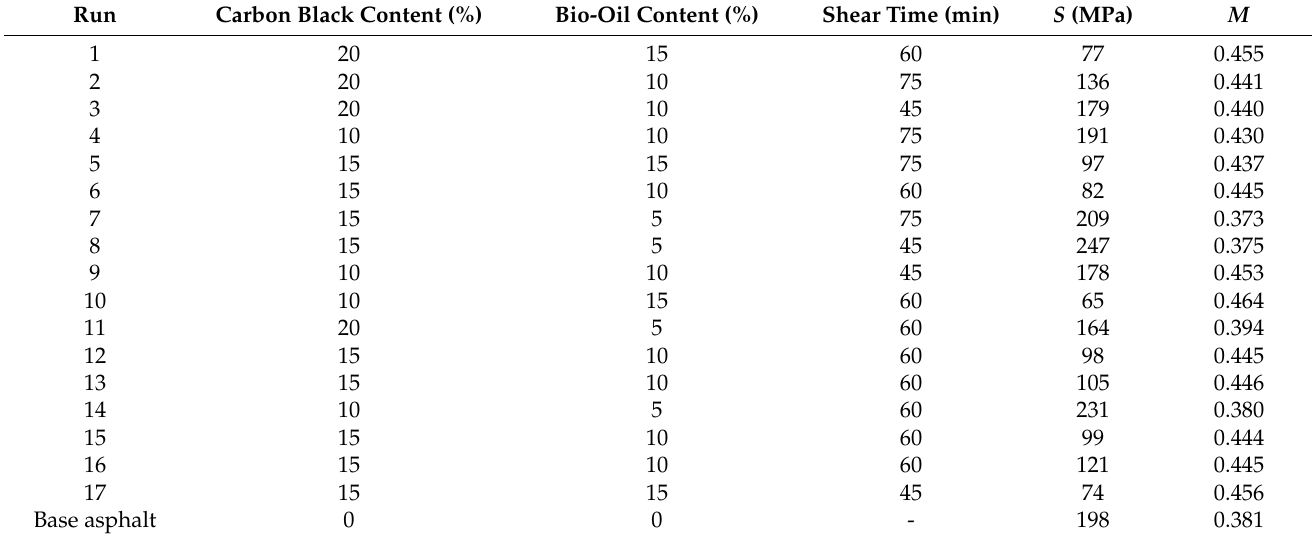
Table 7. The BBR test